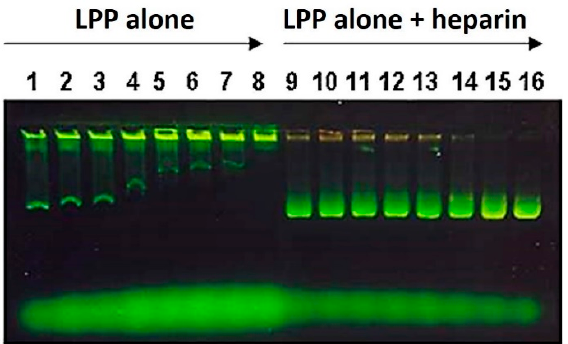
Table 1. Immunization assay groups with the multicompartmental lipopolyplex loaded with hydrosoluble protein antigens (TMP). Vaccine